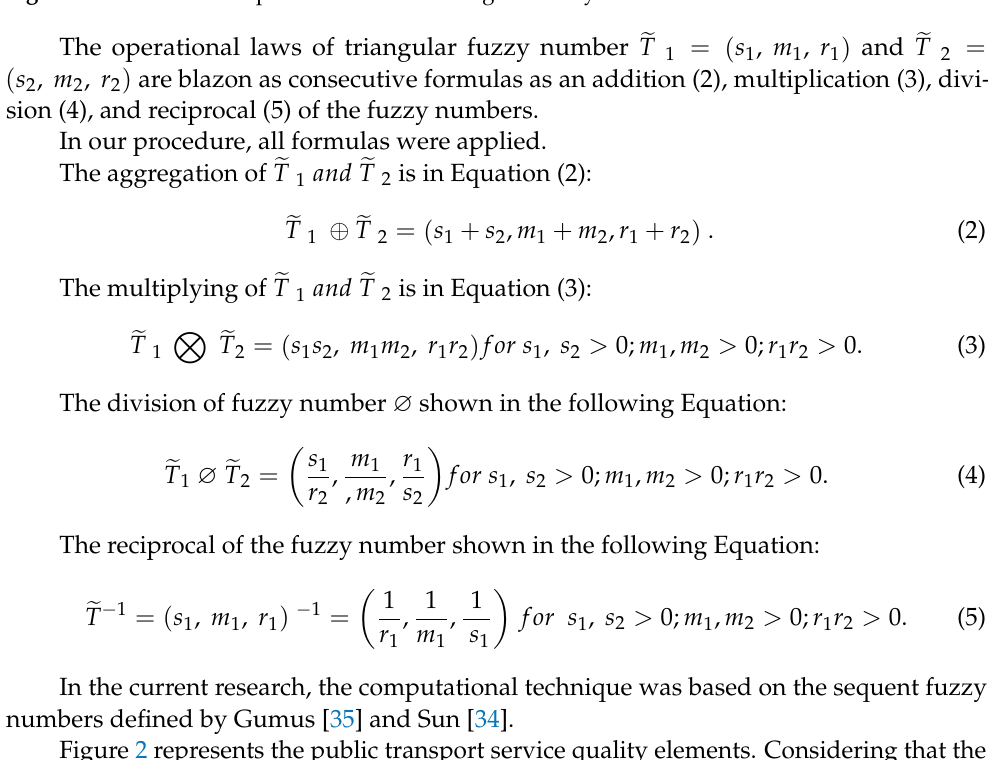
= (𝑠 , 𝑚 , 𝑟 ) and 𝑇̃ = 1 1 1 1 2